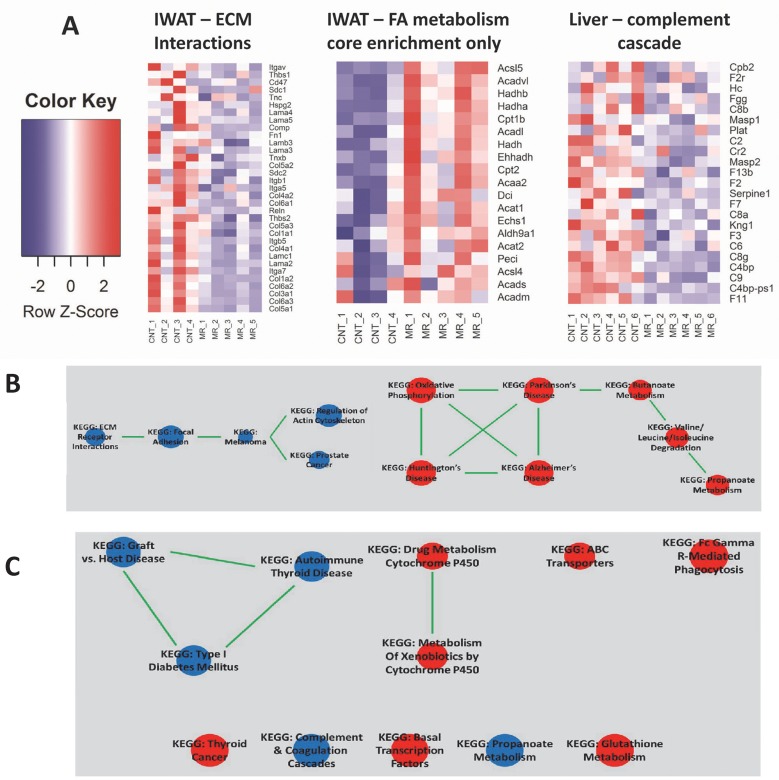
Pathway enrichment analysis based on transcriptomic response to MR.(A) Examples of top-scoring KEGG pathways in IWAT and liver, identified by gene-set enrichment analysis (GSEA). The heatmaps show expression patterns for the genes contributing to core enrichment of ‘Fatty acid metabolism’ pathway in IWAT and ‘Complement cascade’ pathway in liver (blue and red indicated lower and higher expression levels, respectively. (B) Gene overlap among top-scoring pathways in IWAT. Up-regulated and down-regulated pathways in MR are shown in red and blue respectively. Pathways sharing >50% of their genes are connected via a green edge. (C) Overlap among top-scoring pathways based on gene expression data in liver. GSEA significant pathways (FDR<0.1) were analyzed via the Enrichment Map application in Cytoscape (v3.4.0) for identifying pathways with >50% overlap in their component genes. Pathways upregulated in MR-treated liver samples are shown in red and downregulated pathways are shown in blue.